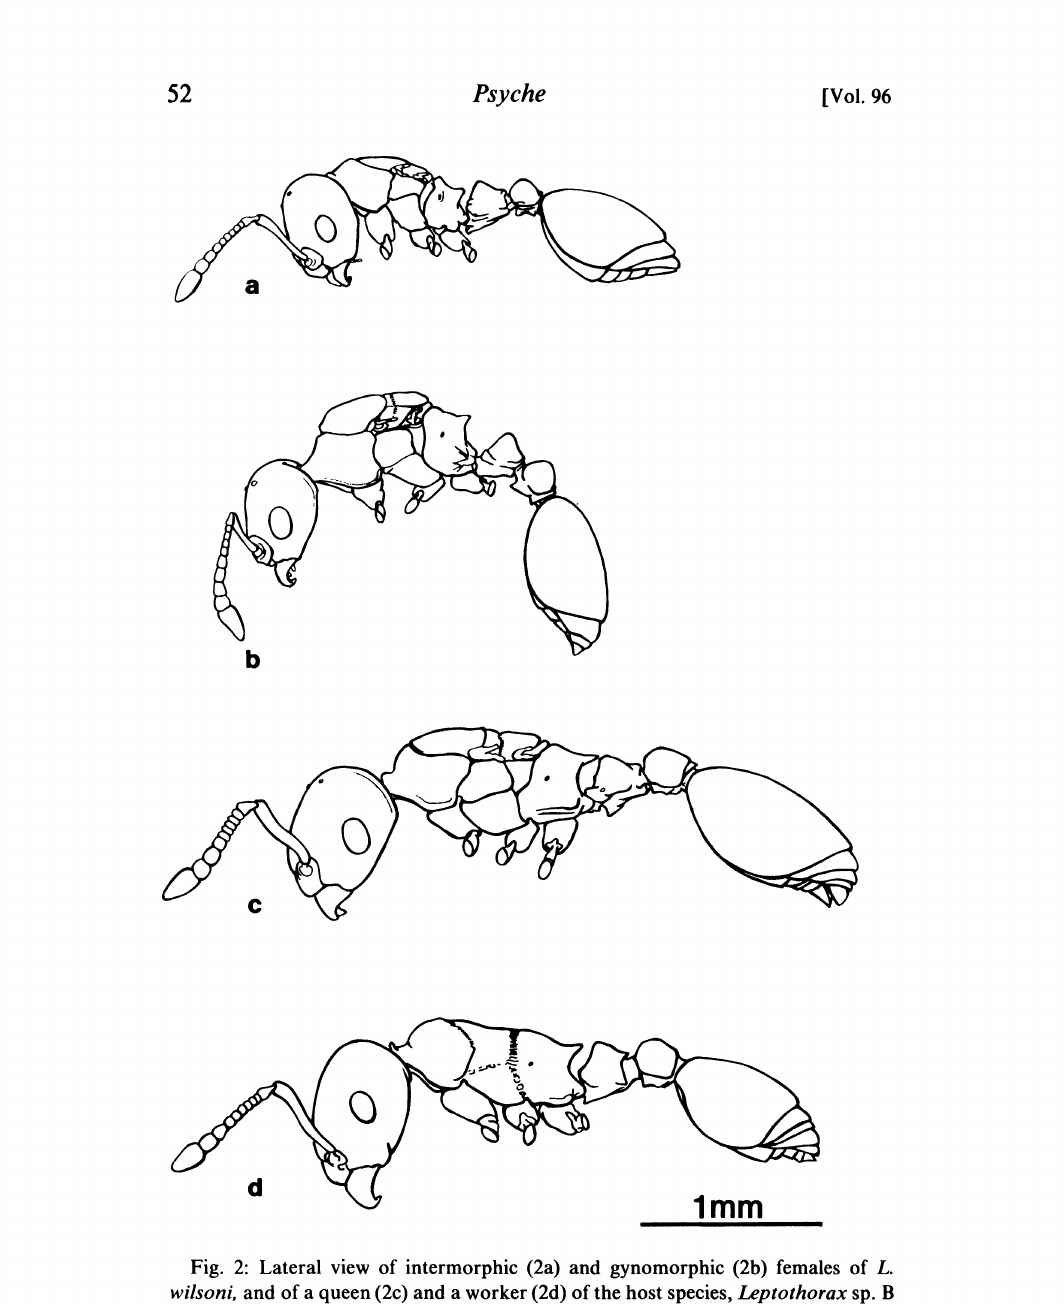
Fig. 2: Lateral view of intermorphic (2a) and gynomorphic (2b) females of L. wilsoni, and of a queen (2c) and a worker (2d) of the host species, Leptothorax sp. B of the "L.